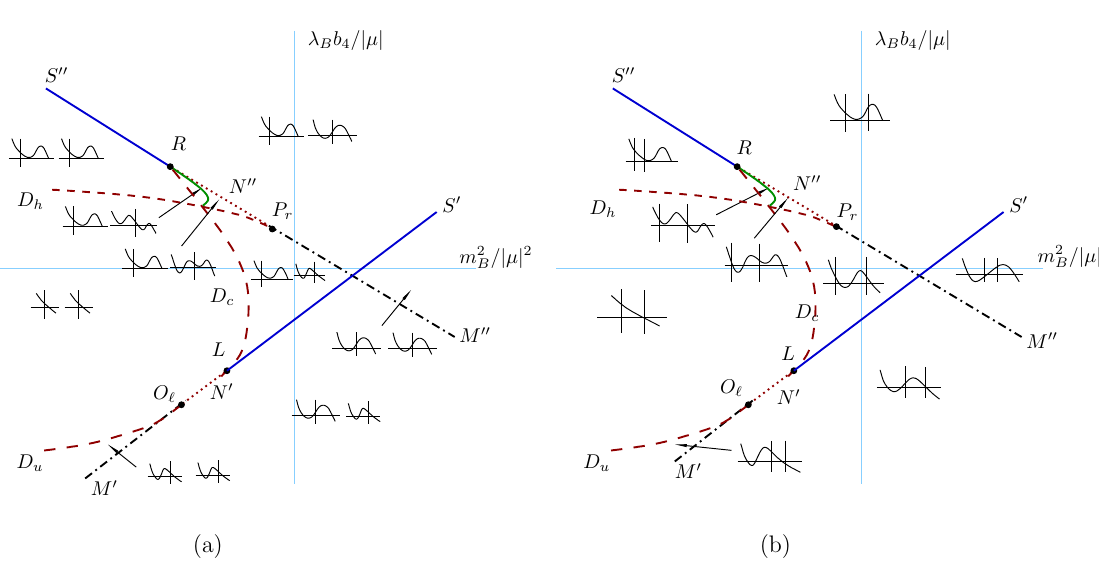
Figure 33 . Structure of the potential for x B < φ h . Refer to sections 7.2.1 and 7.2.2 for the labels 6 of the various points and lines. We have restored the | µ | dependence of the phase diagram by rescaling m 2 and λ B b 4 by appropriate powers of | µ | . B